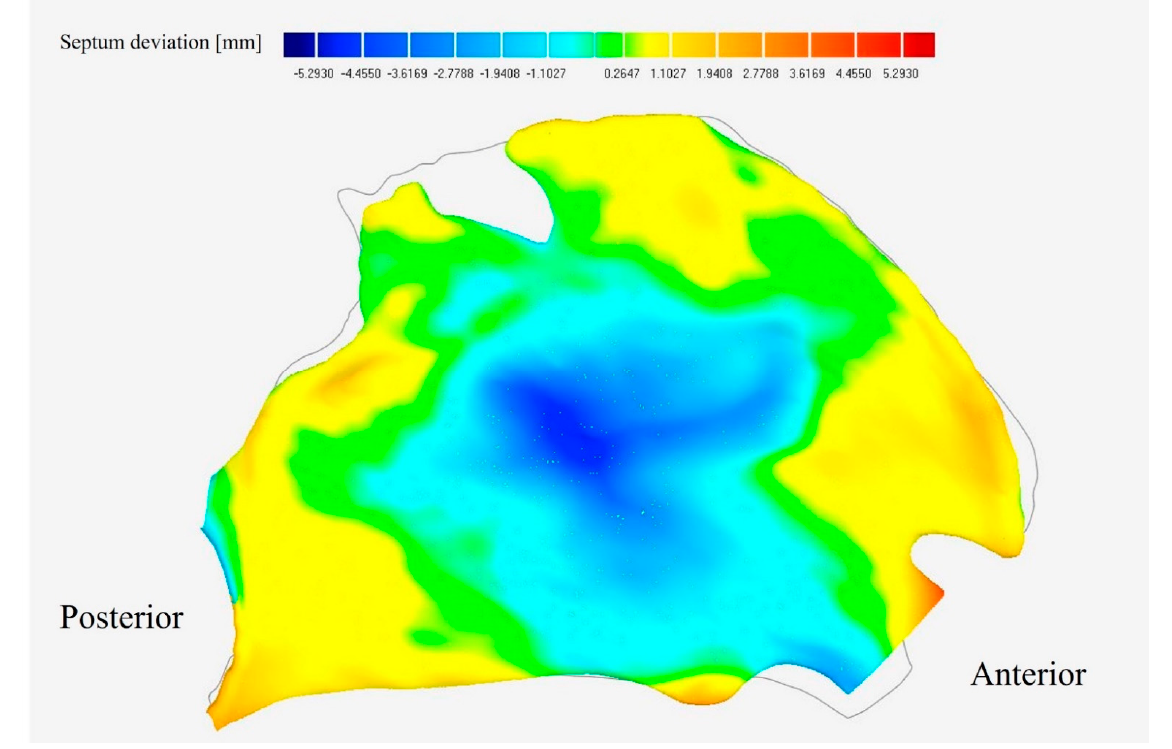
Figure 5. Septum deviation colourmap, where red represents deviated to left and blue is the opposite. Left septum was used as the reference location and the right septum was analysed.